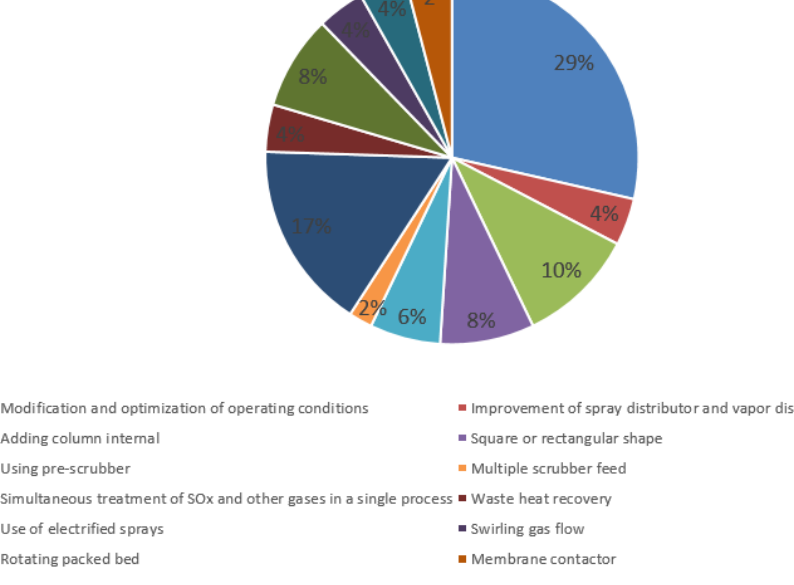
Figure 3. Percentage of articles mentioning different solutions for improving SWFGD process.